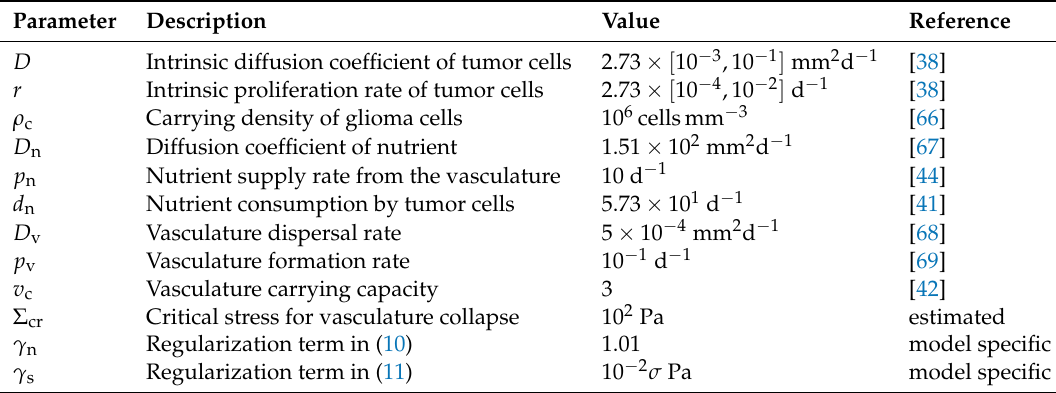
Table 1. Model parameters used in the